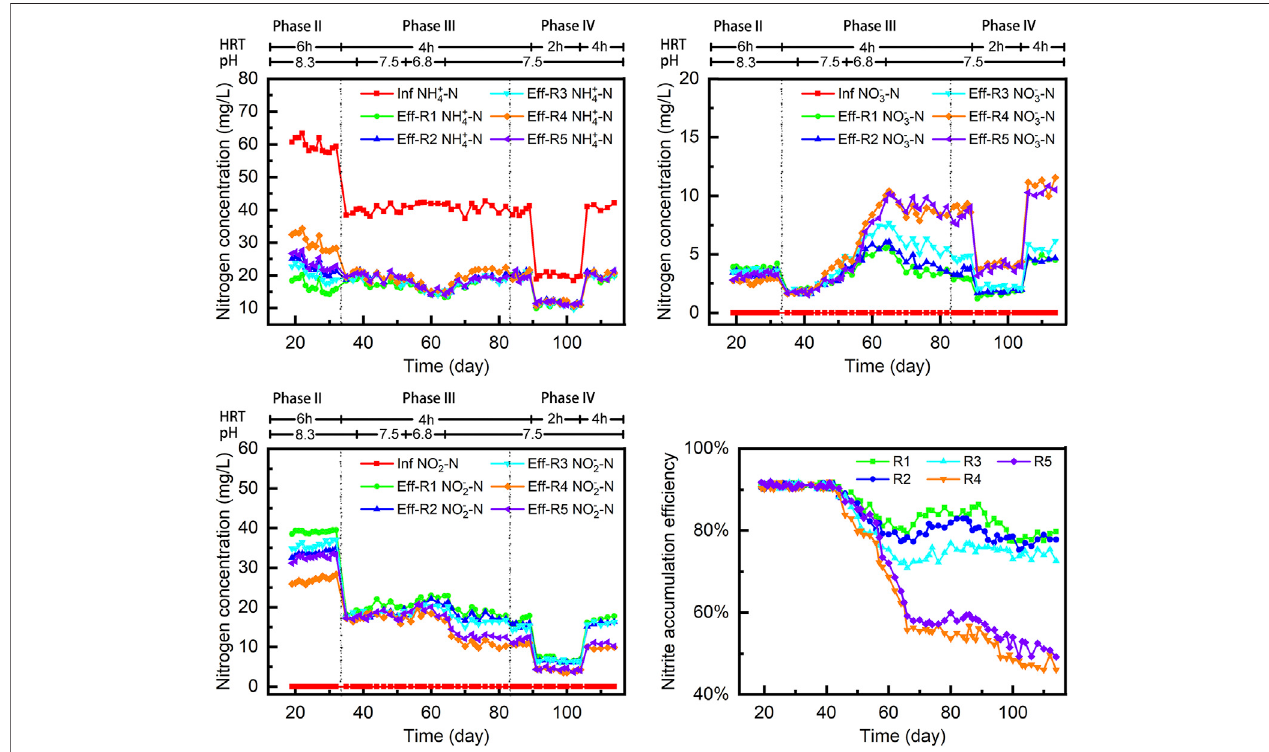
FIGURE 2 | Performance of these reactors during fi rst 115 days ’ operation (phases I –